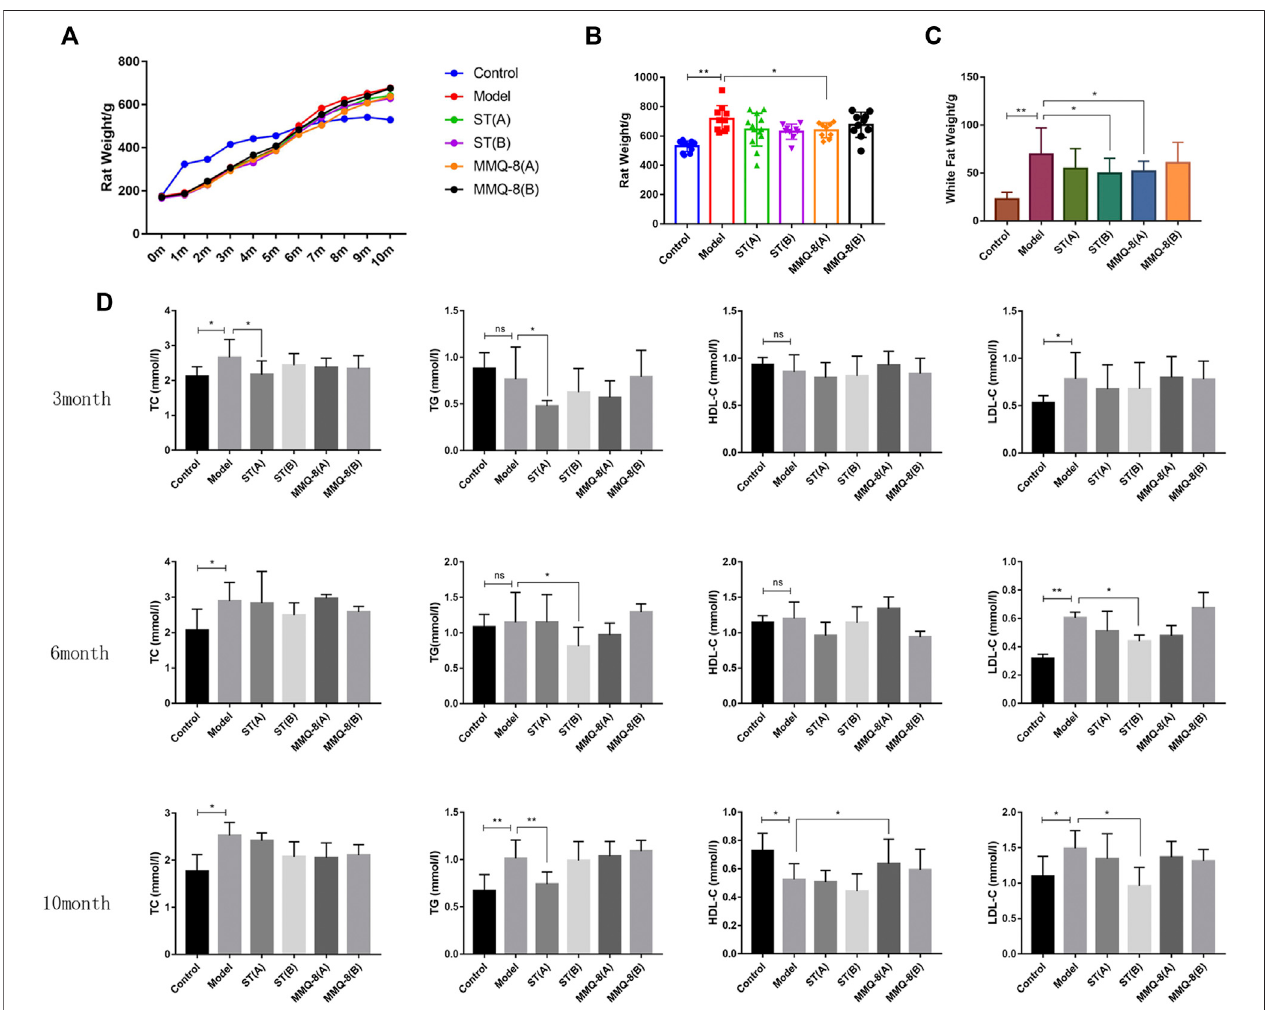
FIGURE 3 | MMQ-8 optimizes lipid metabolism in obesity. (A) Statistics of body weight in each month. (B) Results of body weight in the 10th month. (C) White adipose tissue weight, whichincludes adipose tissue abovethe epididymides and around thekidneys. MMQ-8treatmentsigni fi cantly decreased bodyweight and white adipose tissue weight. (D) Levels of serum lipids measured every 3 months. Serum levels of TC, TG, and LDL-C were decreased and the serum levels of HDL-C were increased after MMQ-8 treatment in obese rats with hyperlipidemia. Data are presented as means ± SD, n = 8, * p < 0.05, ** p <